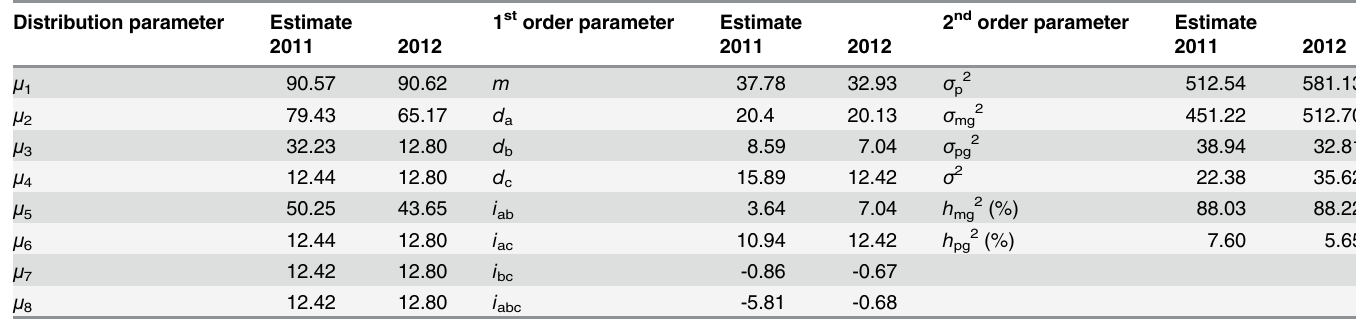
Table 4. Estimates of genetic parameters under the G-0 model over 2 years. Distribution